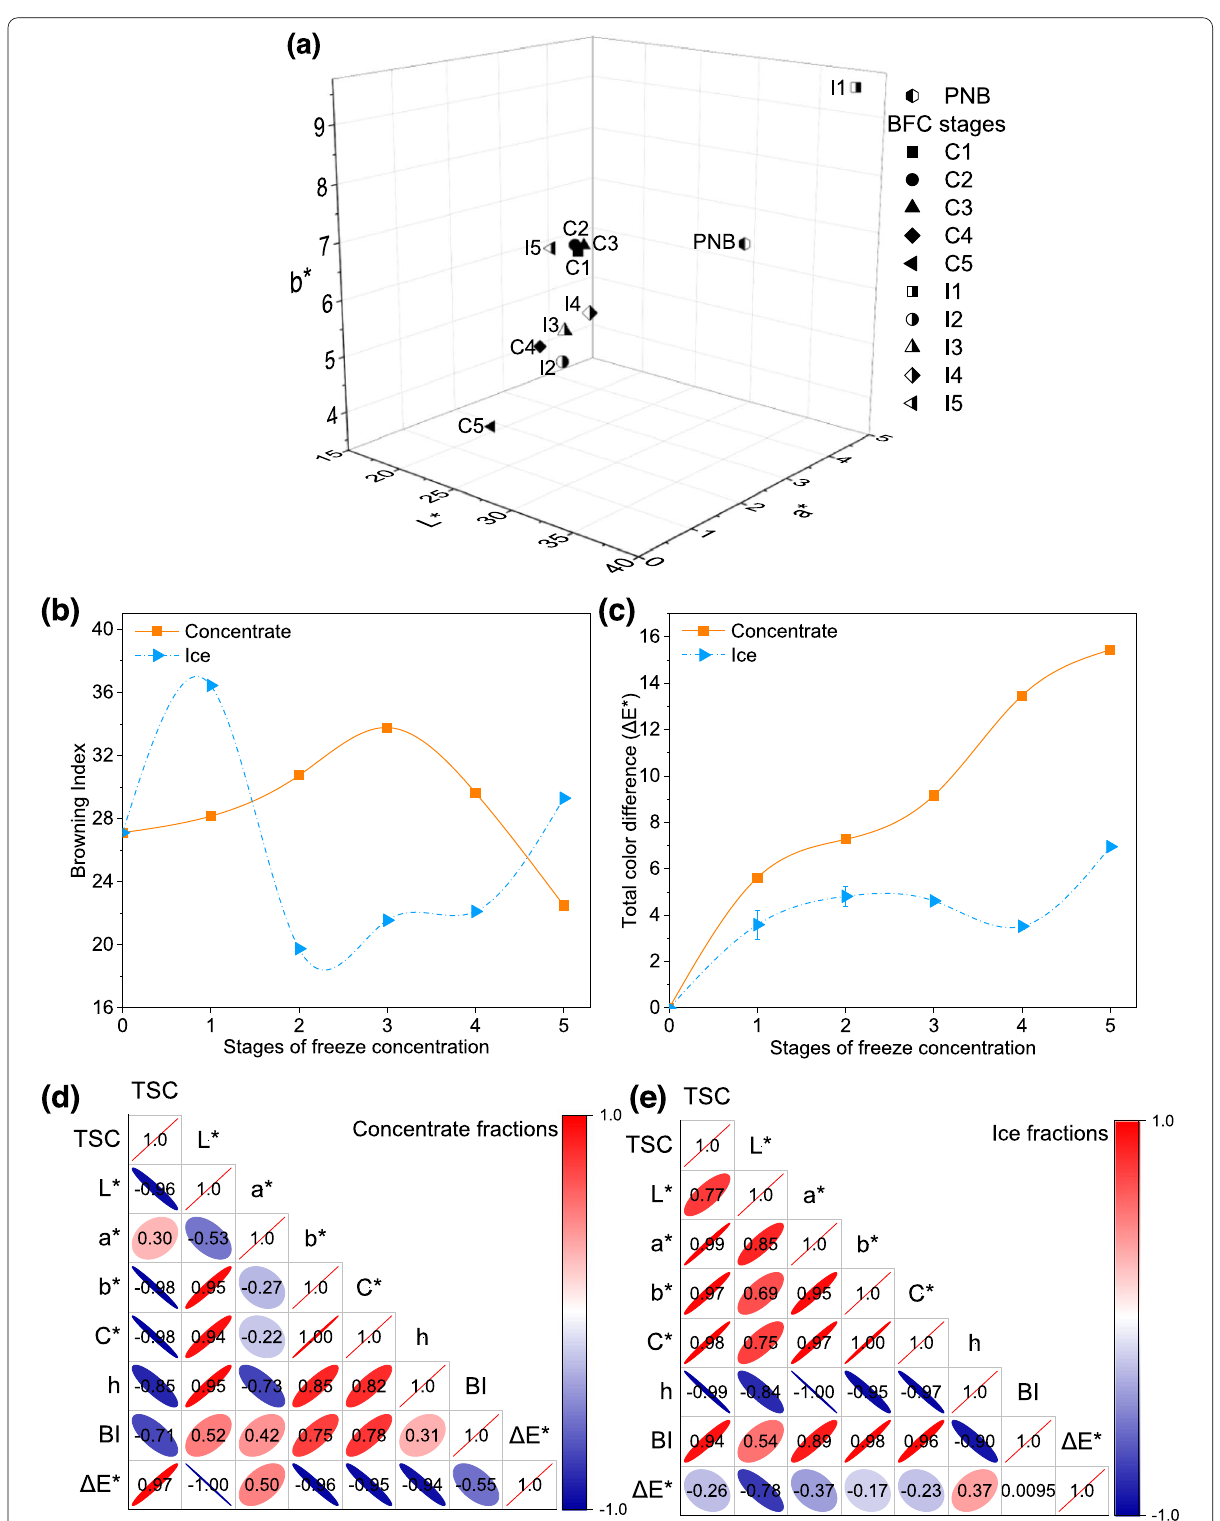
Fig. 2 Evolution of CIELab color parameters ( a ), Browning Index ( b ), total color difference ( c ) and the correlogram for total solids content (TSC) and the color parameters of concentrate ( d ) and ice ( e ) fractions of pecan nut cake beverage (PNB) over five block freeze concentration